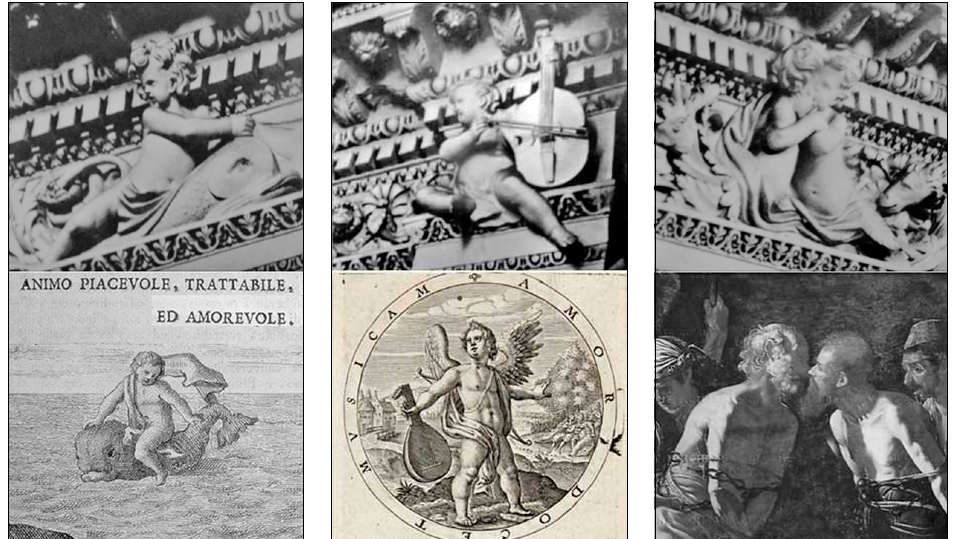
fig. 10. The iconography of putti of St. Peter and Paul’s Church compared to illustration from “Iconologia” book by C. ripa, illustration from “a Collection of Emblemes, ancient and Moderne” by George Wither and “farewell of Saints Peter and Paul” by alonzo rodriguez. Sources : Samalavičius S., Samalavičius a. (1998); http://www.labirintoermetico.com/04Iconologia/iconologia_ ripa_immagini/index.html; http://findingshakespeare.co.uk/the-food-of-love; http://en.wikipedia.org/wiki/Kiss_of_peace.